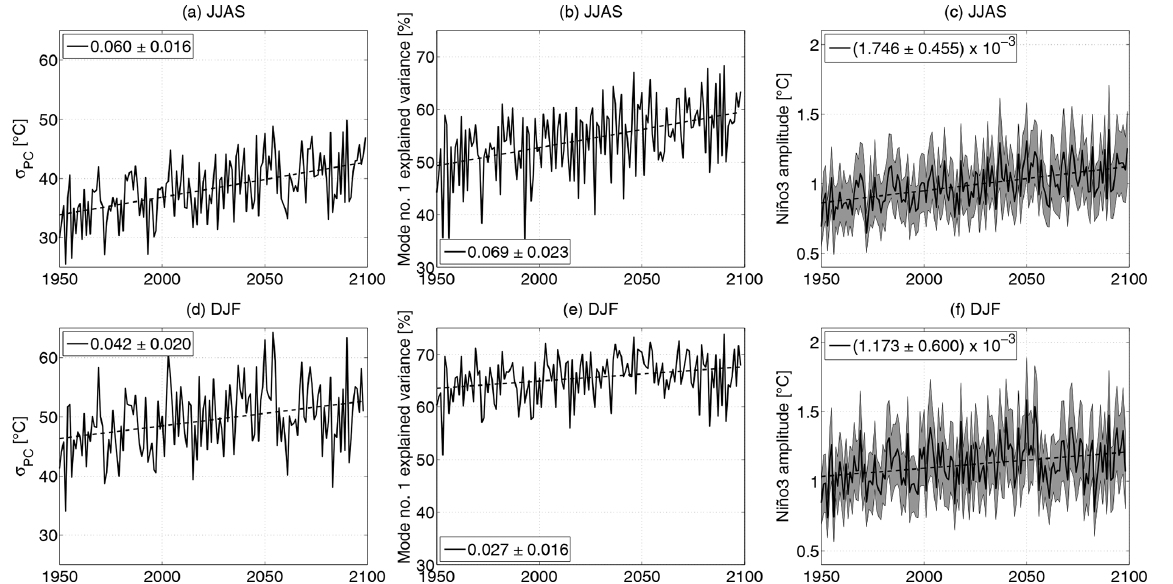
Figure 3. (a, d) Ensemble-based ENSO strength as the ensemble standard deviation of the PC1 ( σ PC ), (b, e) the explained variance in the first SEOF mode, and (c, f) Niño3 amplitude as the area-mean (thick line) ensemble standard deviation of SST in the Niño3 region and its area standard deviation (grey band) in (a–c) JJAS and (d–f) DJF. Linear fits are indicated by dashed lines; legends indicate the slope of the linear fits with 95% confidence